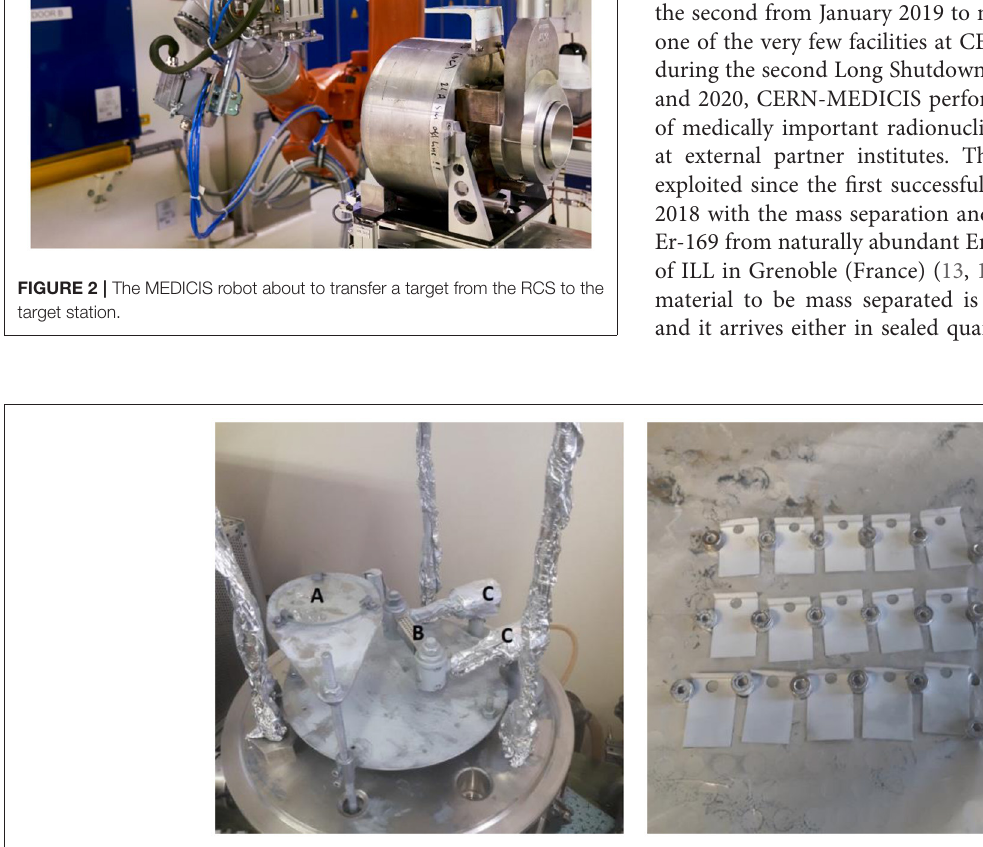
Frontiers in Medicine |